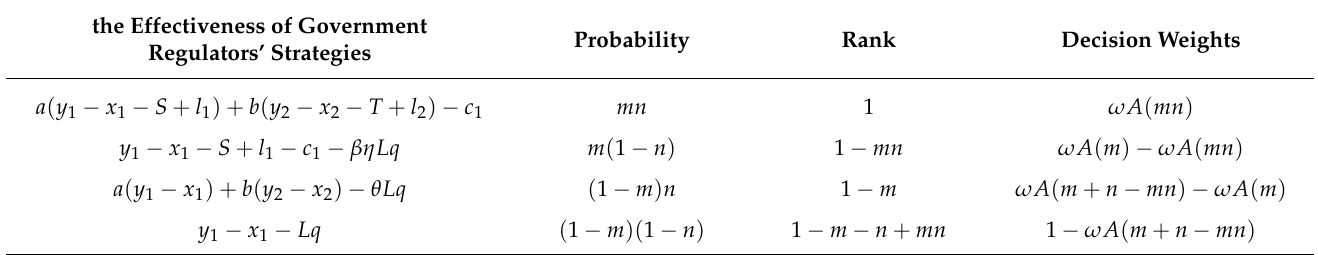
Table 1. Ranking of the expected benefits of government regulators, taking into account sentiment. the Effectiveness of Government Regulators’ Strategies